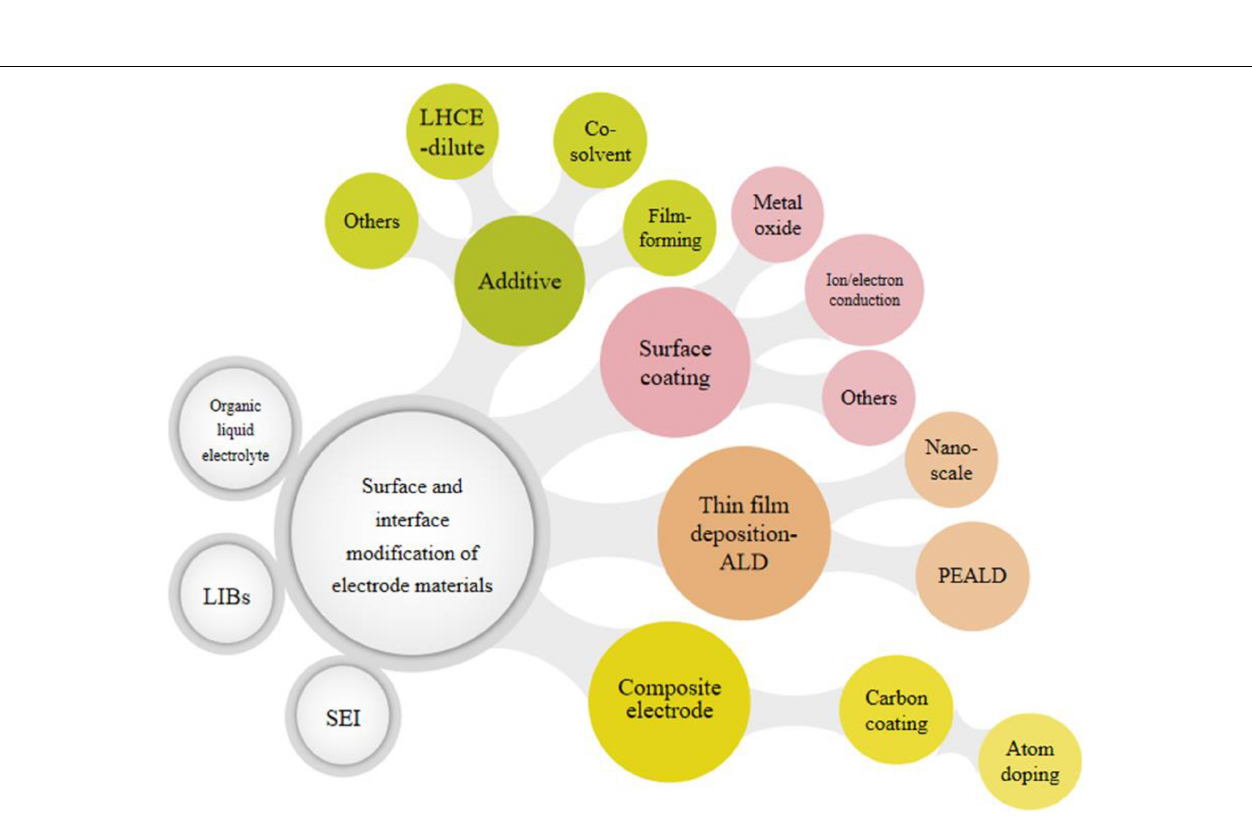
FIGURE 2 | Schematic diagram of surface-interface modification strategies and classification in organic liquid electrolytes for LIBs and map of this review.